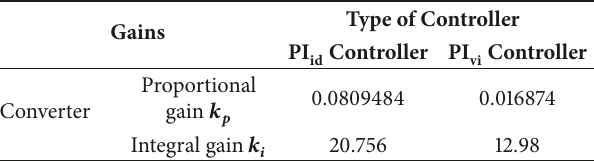
Table 2: Parameters of PI controller for boost